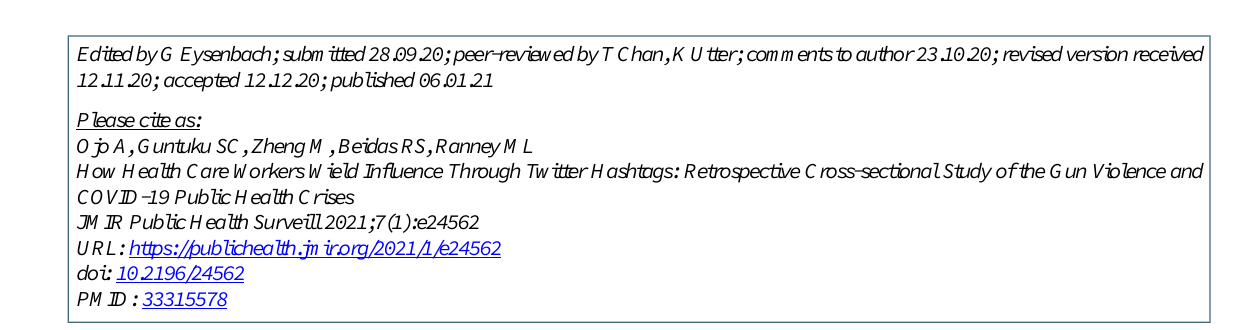
MALLET: Machine Learning for Language Toolkit PPE: personal protective